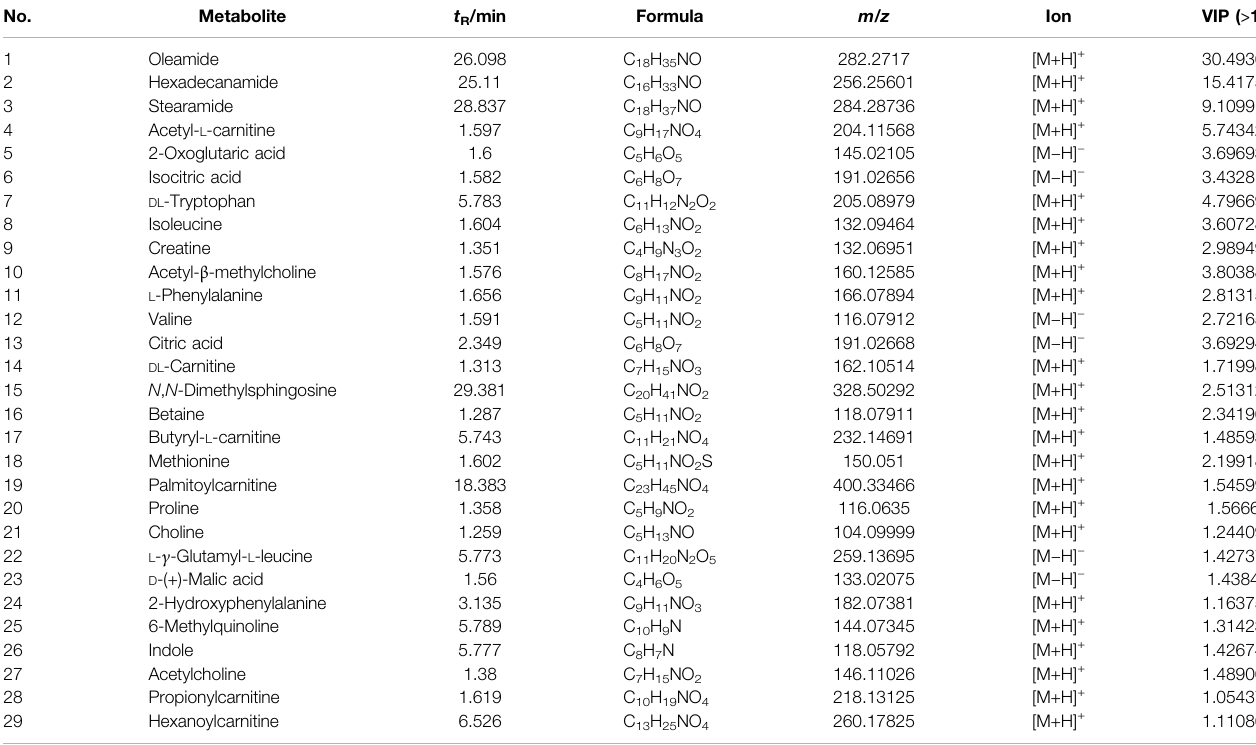
TABLE 6 | Differential metabolites detected in mouse serum by UHPLC-Q-Orbitrap-MS/MS.